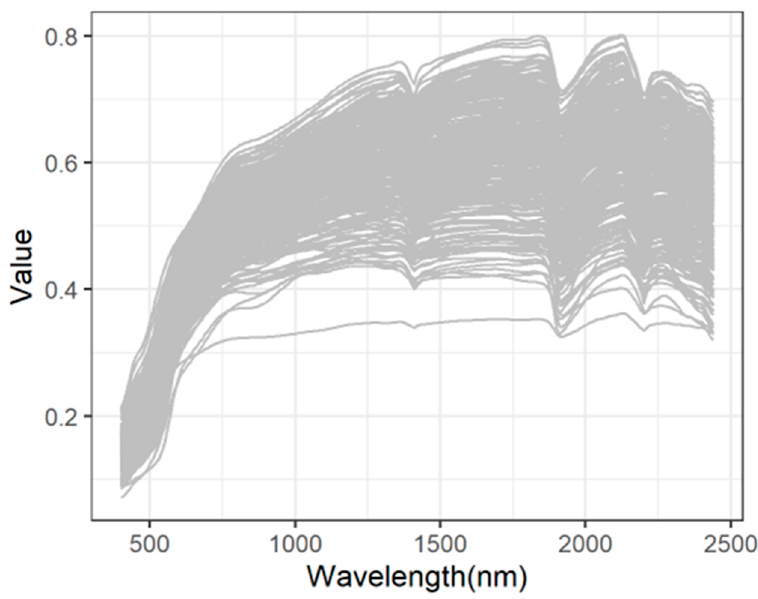
Figure 3. Reflectance of the samples.